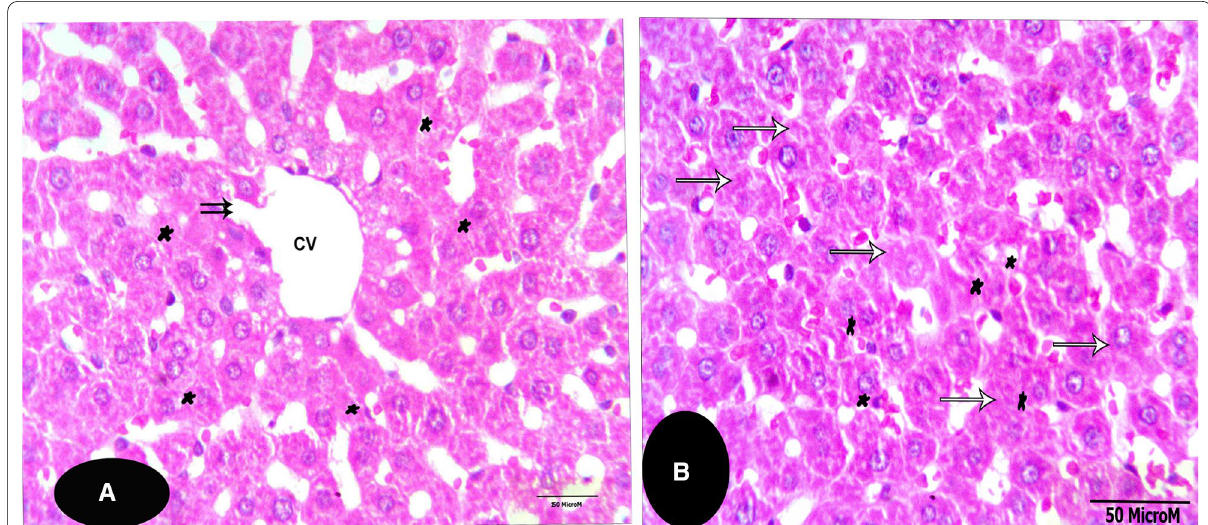
Fig. 3 A , B Photomicrographs of liver sections of G3 (X 400, H&E). A displays a central vein (CV) with a partially eroded wall (arrows). Some hepatocytes display foamy cytoplasm (*), while the rest of hepatocytes are shrunken, and exhibit darkly stained cytoplasm. B shows hepatocytes with foamy cytoplasm (*). The hepatocytes exhibit degenerated and karyolysed nuclei (arrows). The nuclei of other hepatocytes display abnormal chromatin